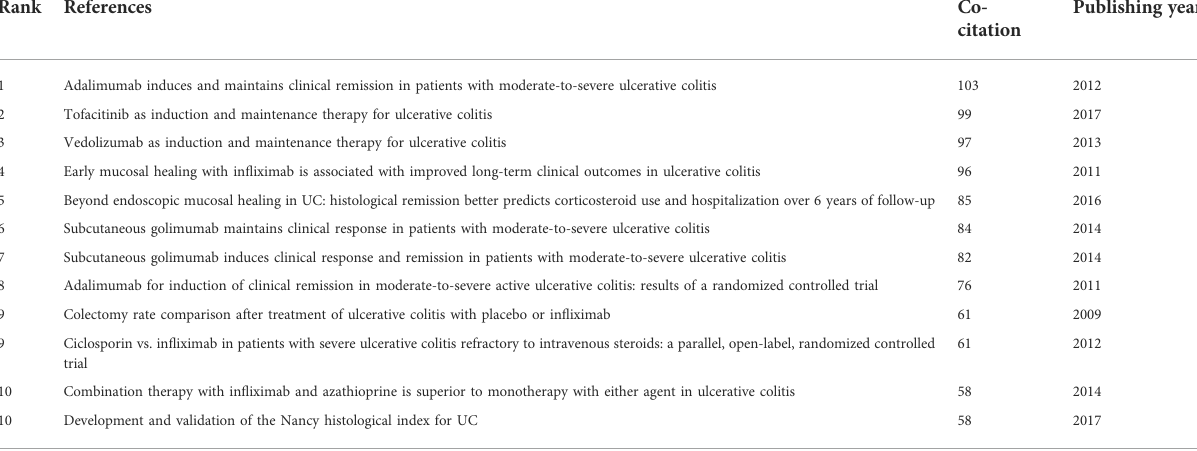
TABLE 6 Top 10 co-cited references in UC